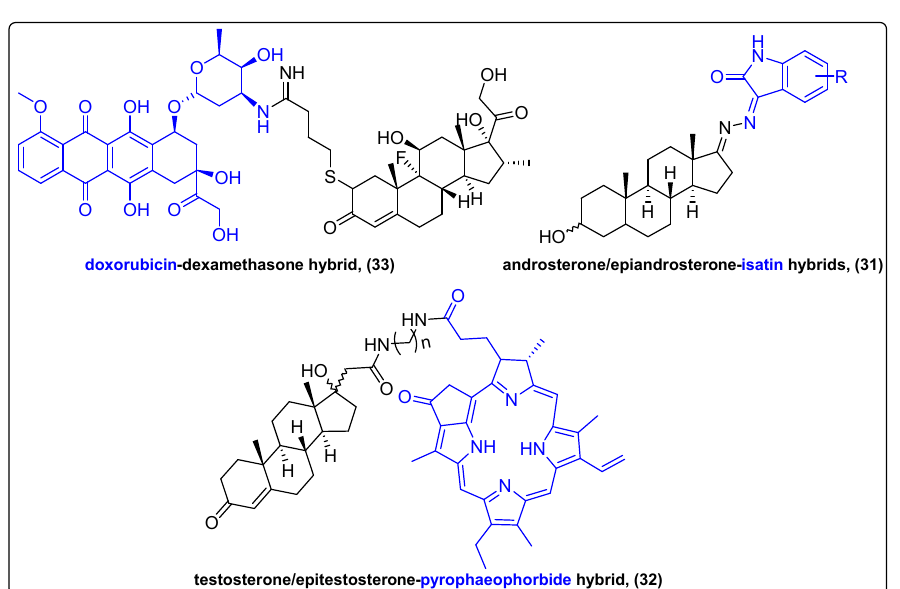
Figure 10. Steroidal hybrids of natural products.